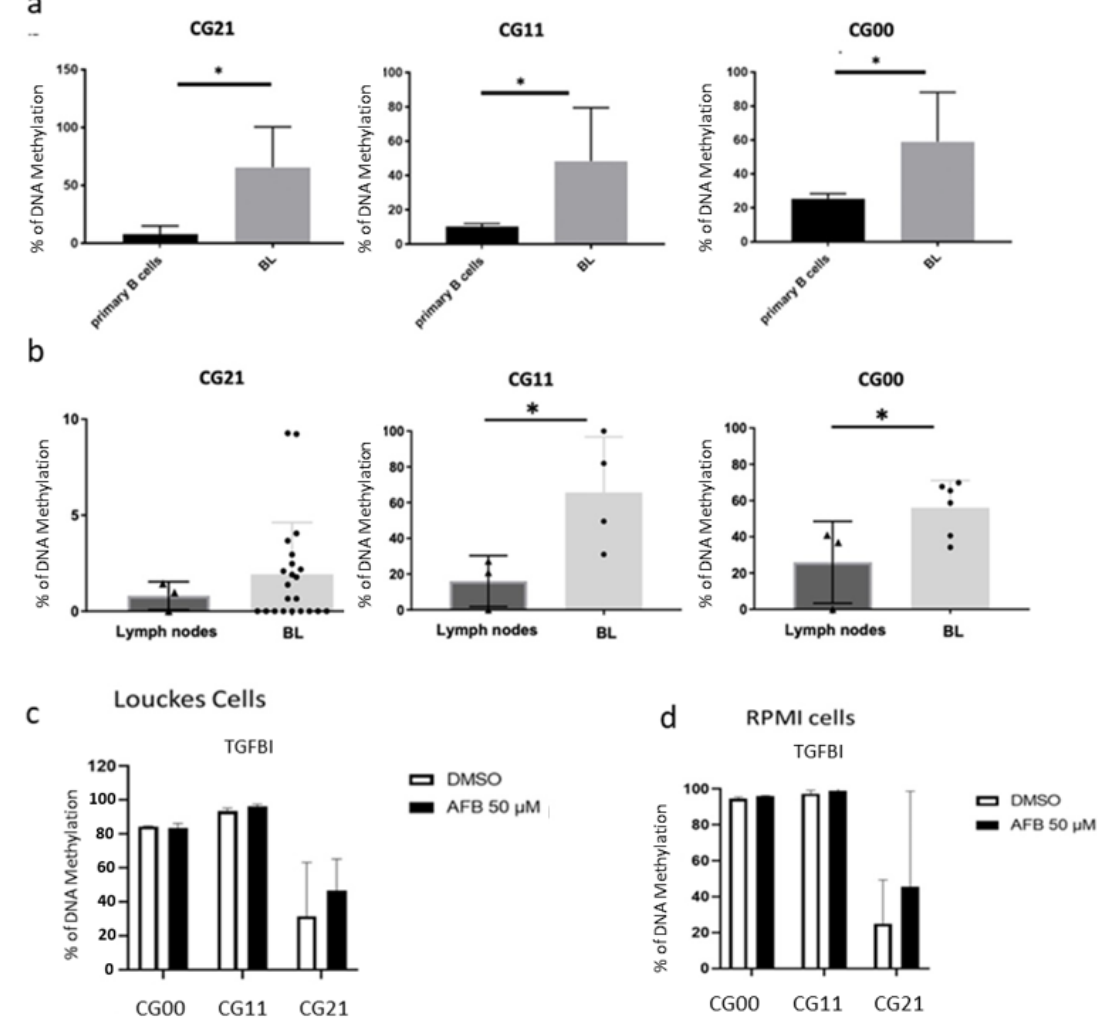
Figure 2. EBV and AFB1-induced hypermethylation of TGFBI promoter. ( a ) Pyrosequencing-based quantification of methylation levels within the TGFBI CpG sites previously identified-CG21, CG11, and CG00–in primary human B cell s and EBV(+) BL derived cell lines ( b ) and in eBL samples (n = 20) vs. healthy patients lymph nodes. Statistical significance was determined by Student’s t test (* p < 0.05). Error bars in the graphs represent the standard deviation. ( c , d ) Pyrosequencing analysis of the methylation levels within the same CpG sites in EBV(-) BL cells in vitro treated with AFB1 for 48 h; n =